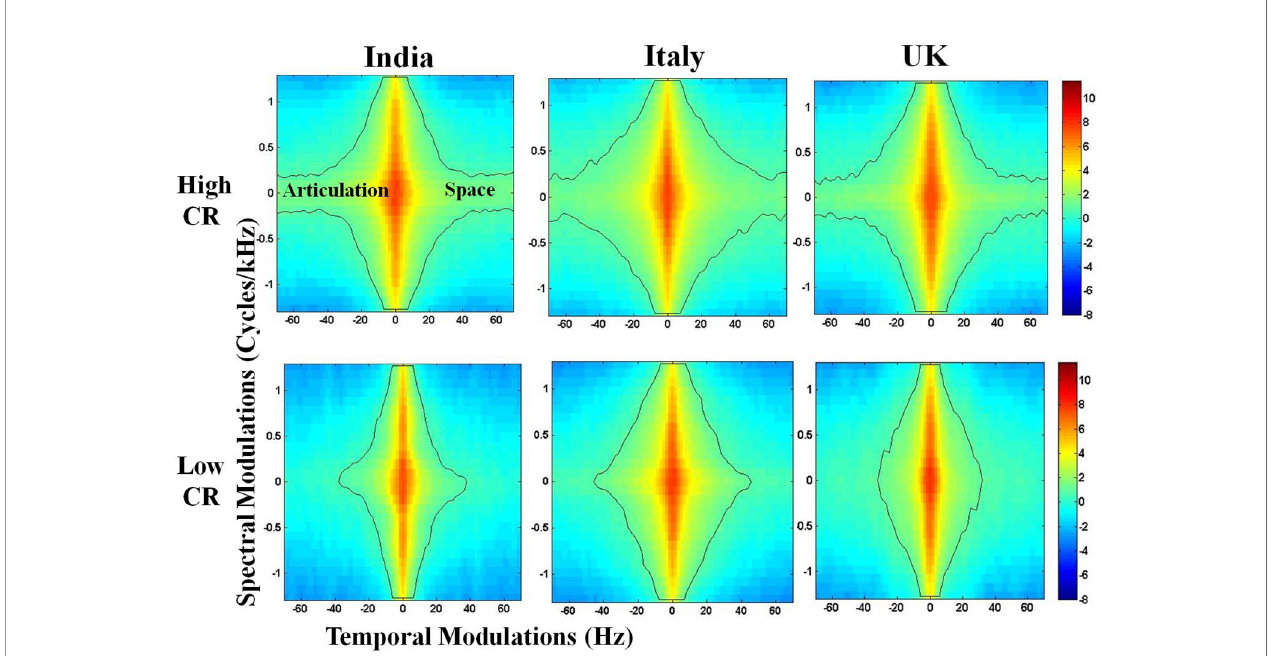
FIGURE 1 | Representative speech modulation spectra for individuals rated high and low on closeness rating (CR) from three countries. Articulation Space is quanti fi ed through the number of pixels enclosed within the contour, and encompasses 99.9% of the energy in the distribution of spectro-temporal modulations.